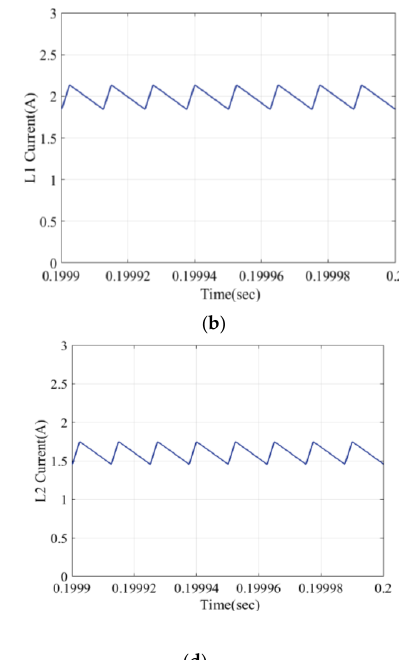
, ( c ) experimental results for I L 1 2